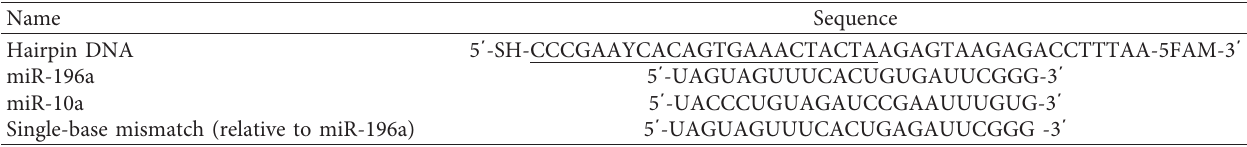
Table 2: Sequences of DNA hairpin sequence, target miRNAs, single-base mismatch, and noncomplementary